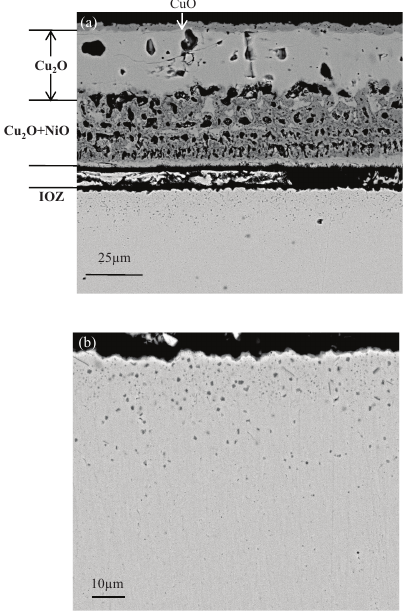
Figure 7. BEI micrographs of a cross section of Cu-4Ni oxidized at 800 °C in 1 atm O 2 for 30 min. (a) General view; (b) Enlarged view of the